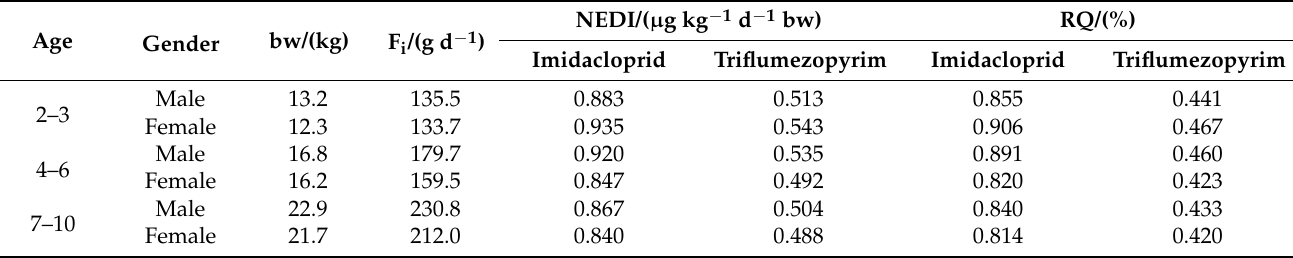
Table 4. Long-term intake assessment at the different age